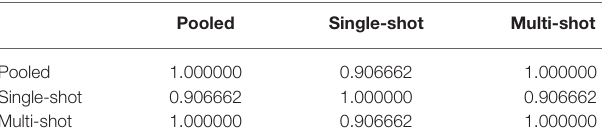
TABLE 2 | Correlation between R 2 from pooled, single-shot and multi-shot regression.